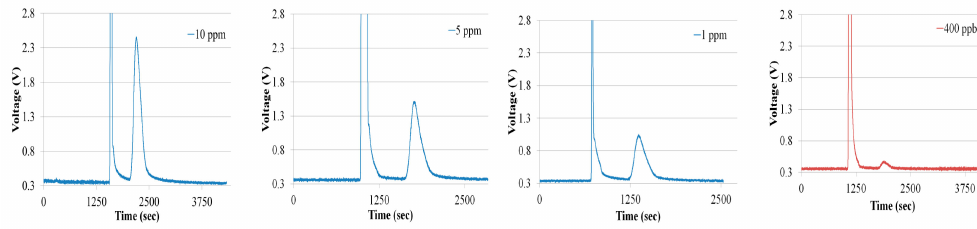
Figure 10. Gas chromatographic system characterization at 10 ppm, 5 ppm, 1 ppm and 400 ppb, respectively.